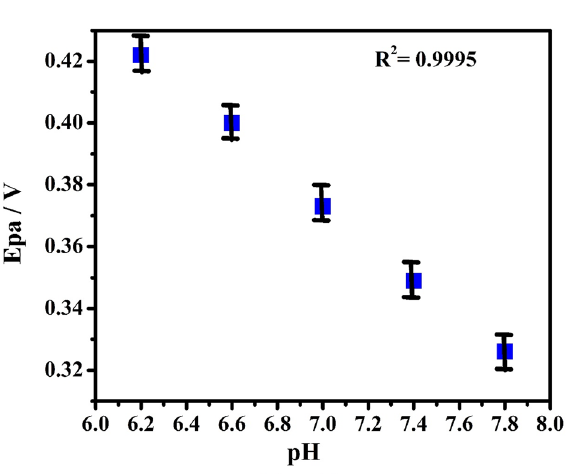
Figure 13. Graph of Epa vs varied pH for PA.